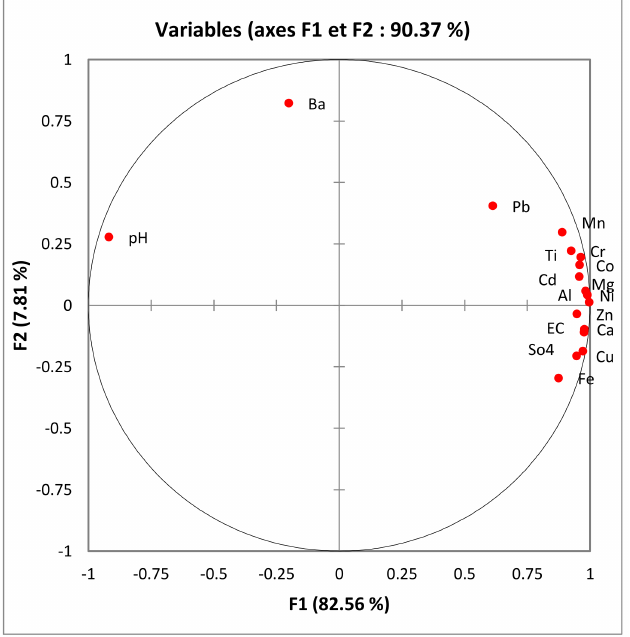
Figure 8. Principal component analysis for sampled water during first campaign: projection of variables on the plane F1-F2.